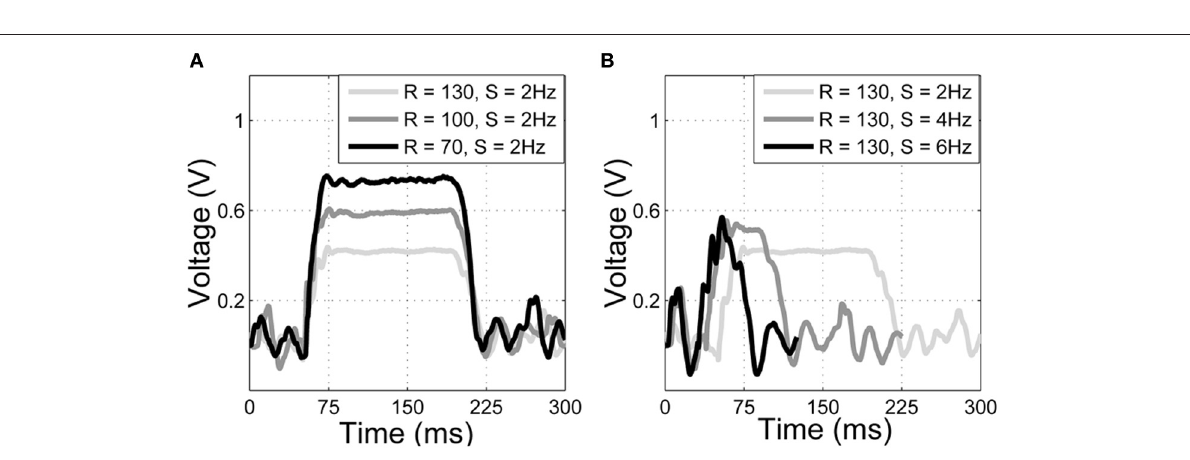
FIGURE 9 | Raw data from SCRATCHbot. Properties of the deflections match closely to those from the XY positioning robot (compare with Figure 4 ). (A) three deflections at different radial distances (R, in mm), but the same speed (S, in Hz). Peak